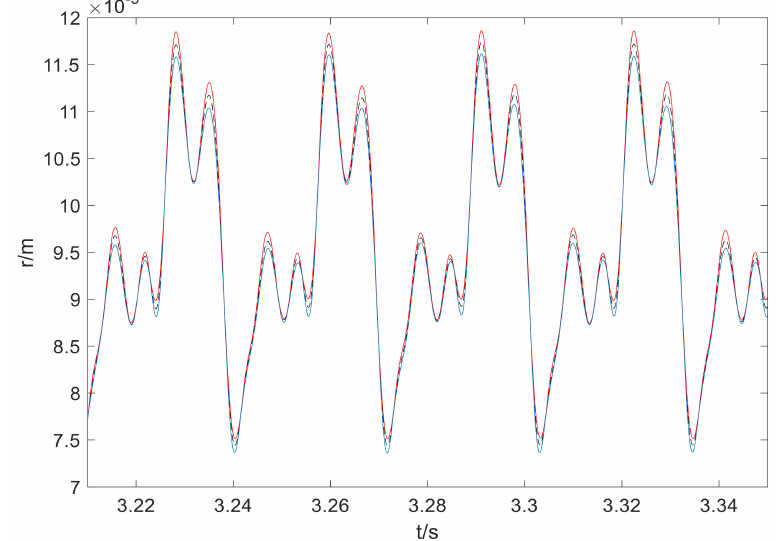
Figure 7. Vibrations of the rubbing rotor with 5% bounded friction coe ffi cient uncertainty: blue solid line = lower bound; red solid line = upper bound; black dotted line = deterministic